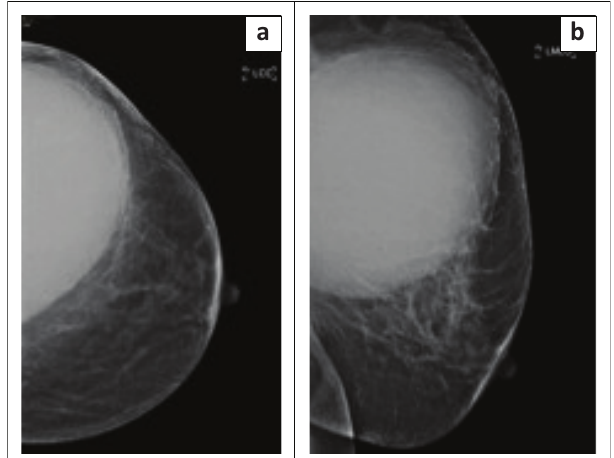
FIGU RE 1: Cranio-caudal view of the left breast on initial mammogram (a) and mediolateral oblique view (b) demonstrating a well-defined, hyper-dense mass within the supero-lateral aspect of the breast.